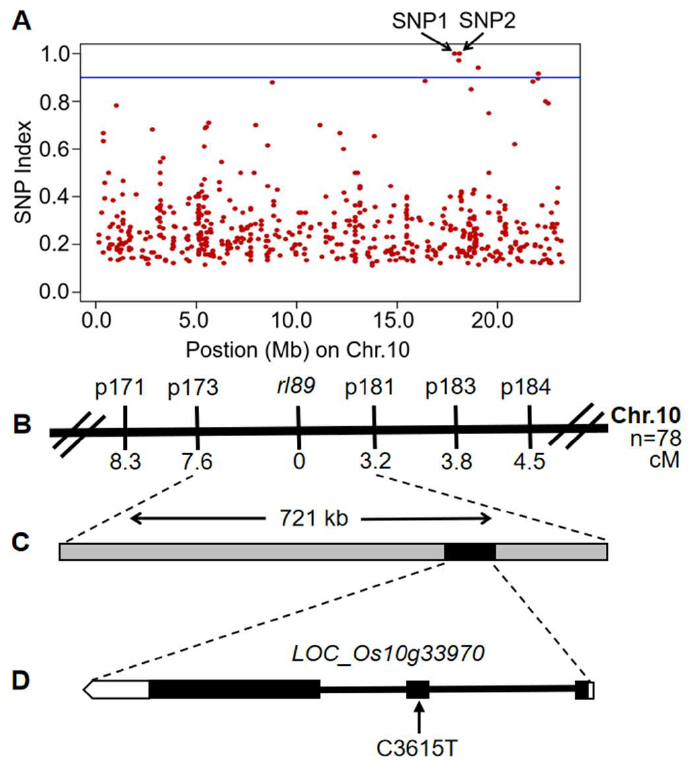
Figure 3. Identification of the causal SNP of the rl89 mutant using MutMap approach and molecular markers. ( A ) SNP index plots for homozygous mutant plants from ( rl89 /188R) F 2 population. ( B ) The rl89 locus was mapped to a region between the InDel markers p173 and p181 on the long arm of rice chromosome 10. ( C ) The physical distance between InDel marker p173 and p181 is 721 kb, among which the black box represents the candidate gene LOC_Os10g33970 . ( D ) LOC_Os10g33970 is composed of 3 exons and 2 introns, and a single nucleotide C-to-T substitution occurred at position 3615 of its coding region in the rl89 mutant. The black squares represent exons, the black lines represent introns, and the black arrow indicates the mutated nucleotide.